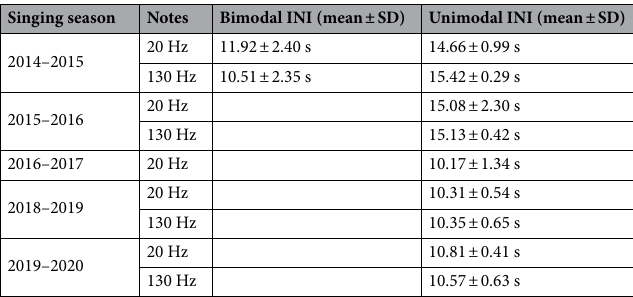
Table 2. Notes and INI patters along the singing seasons